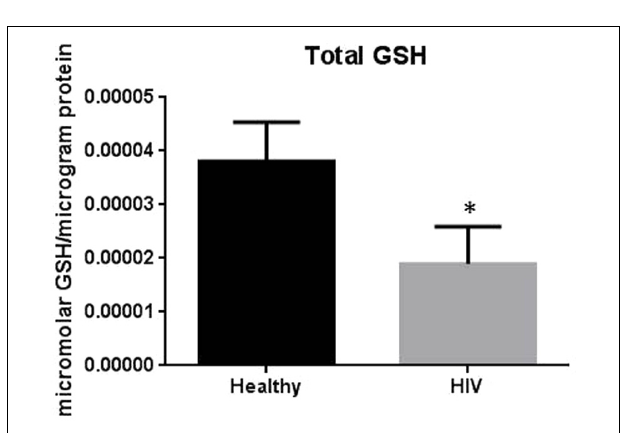
FIGURE 4 |Assay of GSH levels in RBCs from healthy subjects and individuals with HIV infection. Analysis of total GSH which includes both free GSH and GSSG indicated significantly higher levels of GSH in healthy individuals compared to HIV positive subjects. Data in Figure 4 represents significant difference in the levels of total GSH between RBCs isolated from five healthy individuals and five individuals with HIV infection (* p